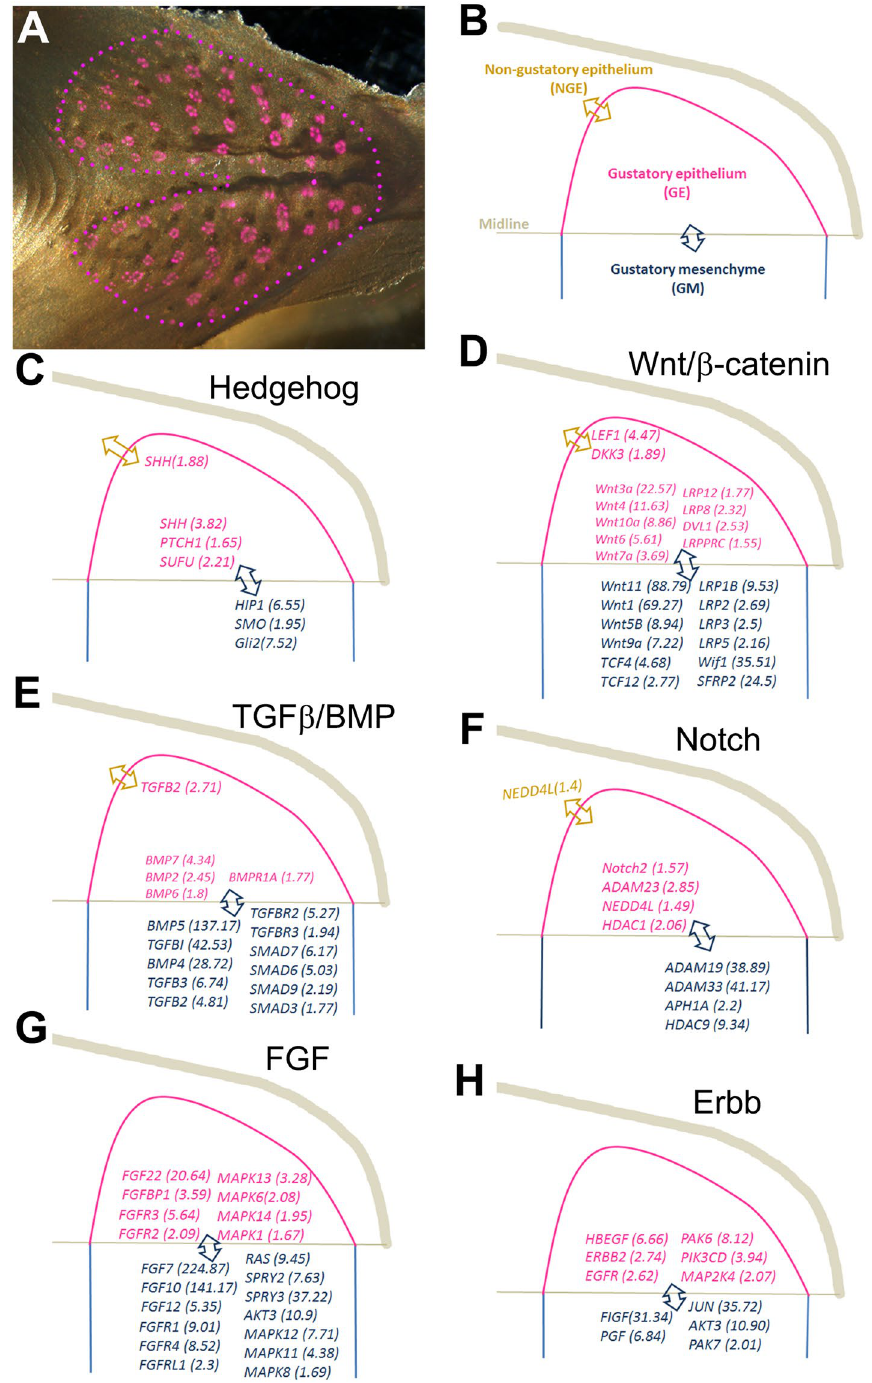
Figure 8. Distribution pattern of highly DEGs that are key components of well-known molecular signaling pathways in organogenesis ( C – H ). ( A ) An epithelial sheet of the base of the oral cavity of a P3 chicken that was immunoreacted with Vimentin for labeling taste buds (purple). Purple dots outline the gustatory epithelium that contains taste buds. ( B ) A diagram to illustrate the tissue compartments collected for RNA-Seq and DEG detection. ( B – H ) Double pointed arrows indicate the tissue compartments for comparisons of gene expressions. Values in parentheses in ( C – H ) represent the fold change of DEGs at a high expression level in the tissue compartment where the gene ’ s name is